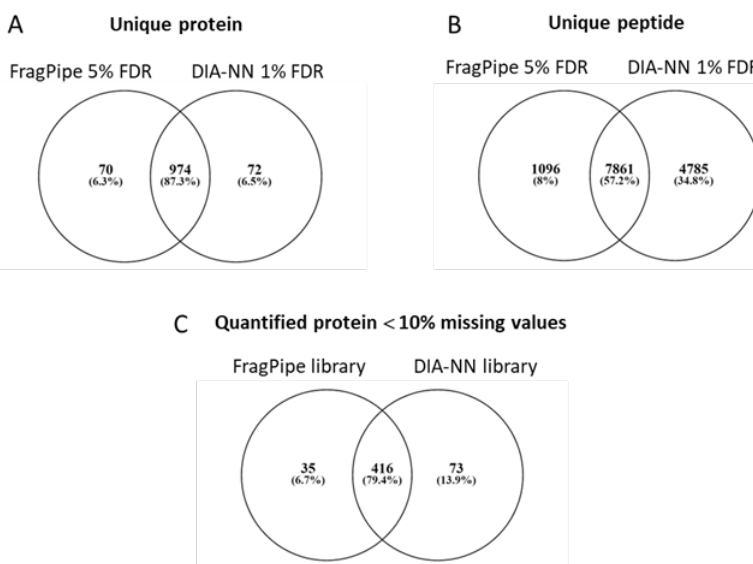
Figure 2. Comparison of libraries and quantified results from FragPipe and DIA-NN analysis. ( A , B ) Venn diagram comparing unique proteins ( A ) and unique peptides (modified and unmodified; ( B )) identified in the two libraries. ( C ) Venn diagram comparing protein groups with less than 10% missing values quantified with DIA-NN using the combined FragPipe library or DIA-NN library-free mode. FDR: false discovery rate.